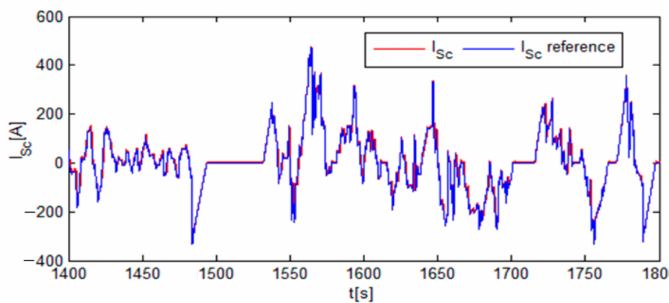
Figure 17. Zoom on the Sc current control result.